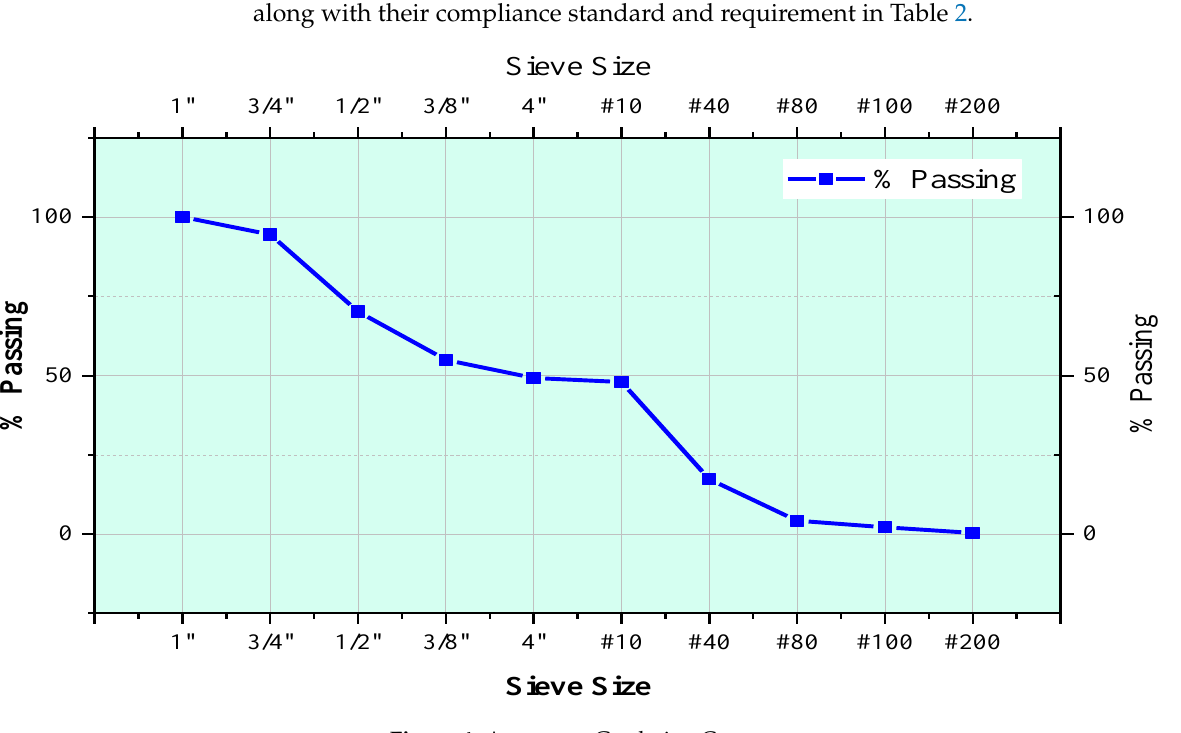
Figure 4. Aggregate Gradation Curve .